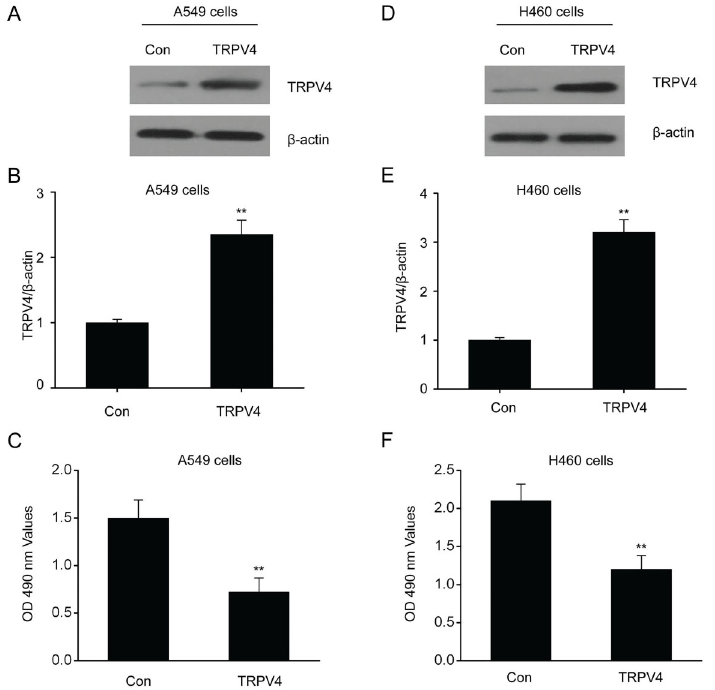
Figure 2. Overexpression of TRPV4 inhibited the proliferation of lung cancer (LC) cell lines. LC cells A549 ( A and B ) and H460 ( D and E ) were transfected for 24 h with the plasmid pcDNA3( + )/TRPV4 (TRPV4) or the control plasmid pcDNA3.1( + ) (Con). Overexpression of TRPV4 was con fi rmed with western blot. TRPV4 inhibited proliferation as assessed via MTT assays in A549 ( C ) and H460 ( F ) cells. Data are reported as means ± SE. **P o 0.01 ( t